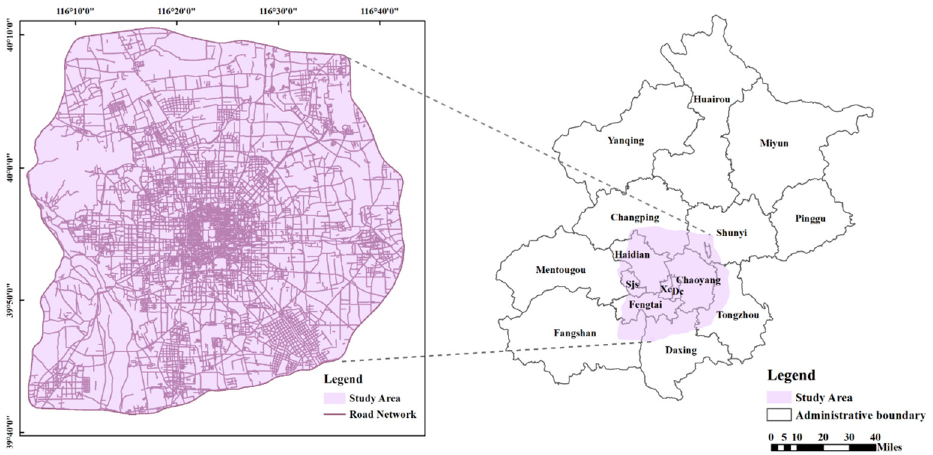
Figure 1. The study area and its road network. Sjs, Dc and Xc are the abbreviations for the adminis- trative districts of Shijingshan, Dongcheng and Xicheng, respectively.